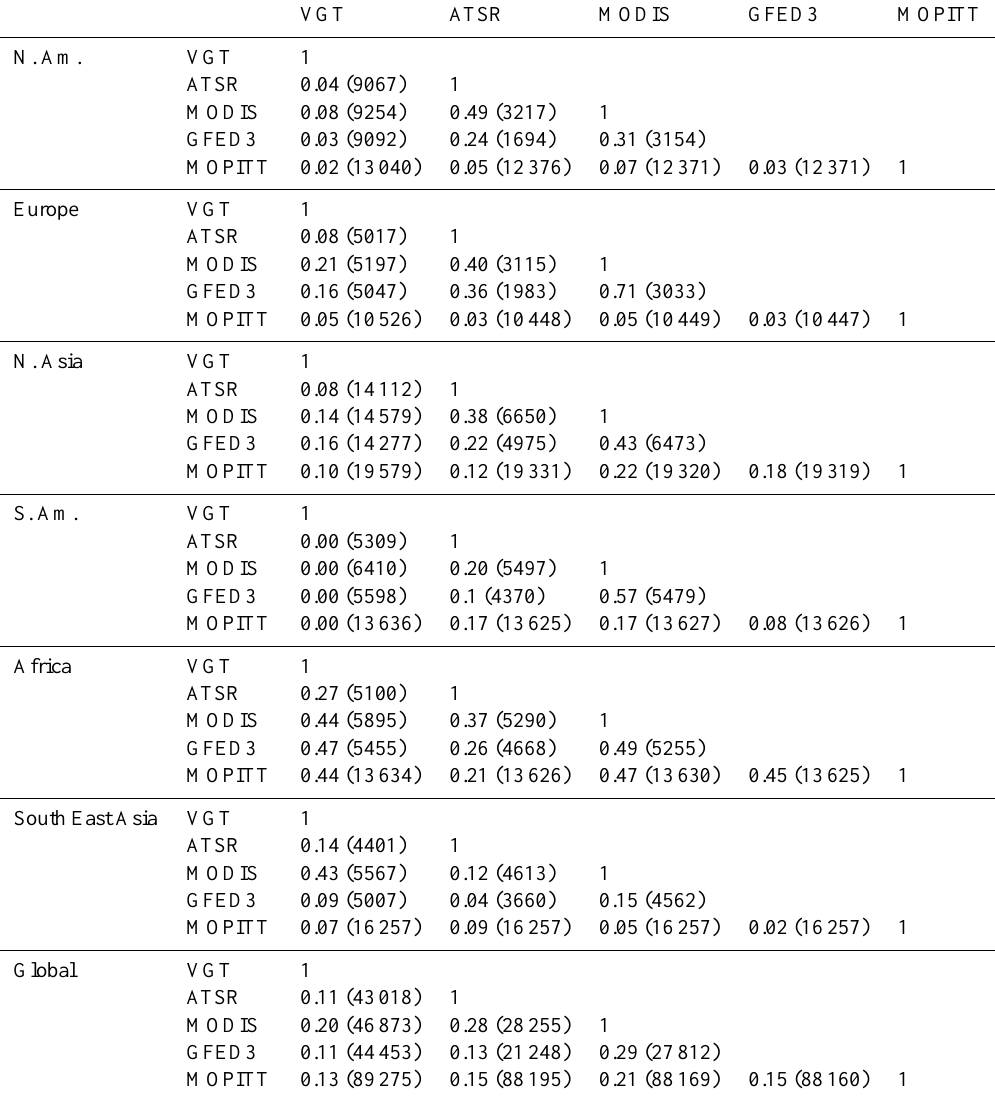
Table 3. The coefficient of determination R 2 derived by regressing CO estimates for the 0.5 ◦ cells for each window and the globe. In the parenthesis the number of cells used in the regression after discarding cells with zero emissions in both products. VGT ATSR